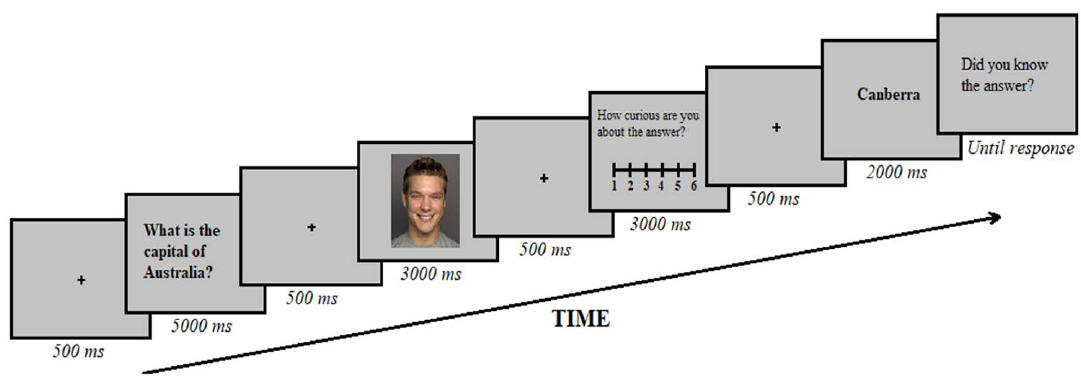
Figure 1. Schematic illustration of the experimental procedure.